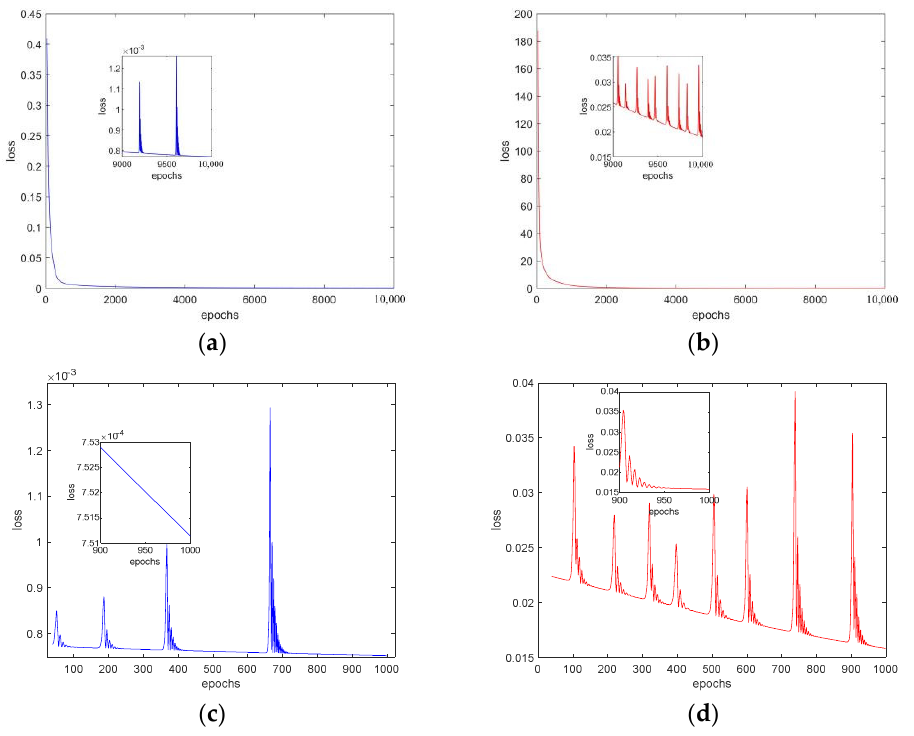
Figure 5. Training results of deep neural network. ( a ) The training loss for sigmoid activation function epochs; ( b ) the training loss for the ReLU activation function; ( c ) the test loss for the sigmoid activation function; ( d ) the test loss for the ReLU activation function.